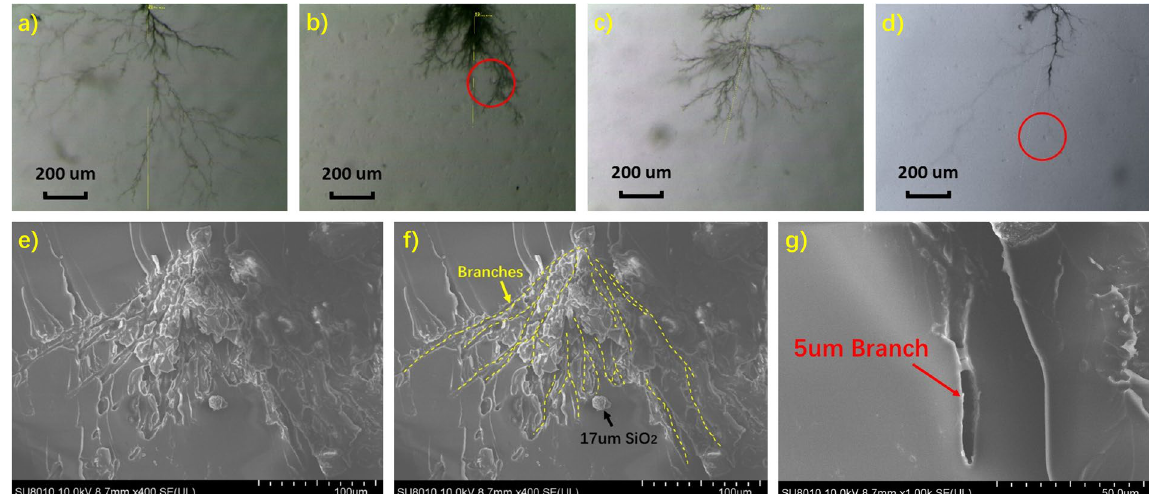
Figure 5. Several typical ways of the electrical tree growth in ( a ) epoxy, ( b ) micro composite, ( c ) nano composite and ( d ) micro-nano composite. SEM images of ( e ), ( f ) an electrical tree with the micro particle and ( g ) a tree